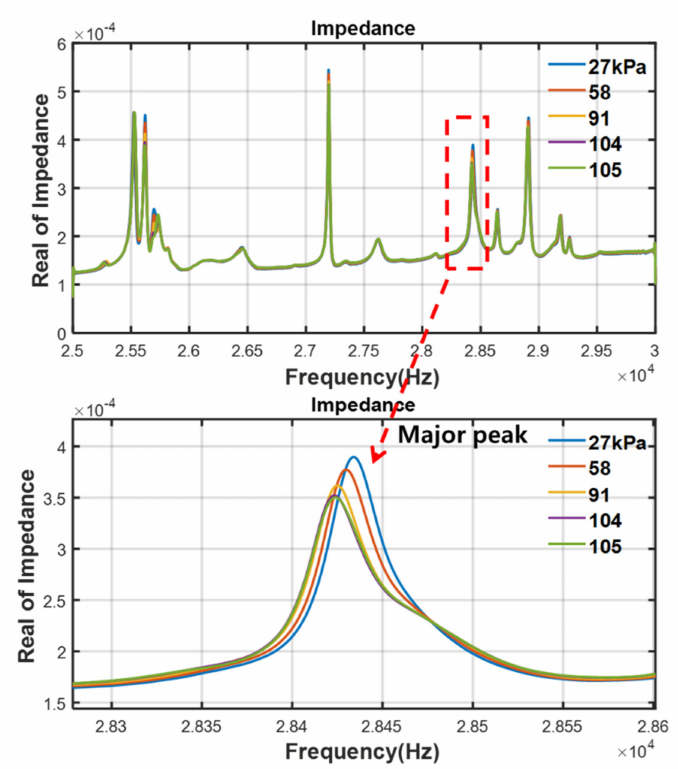
Figure 3. Variations in EMI according to internal pressure (test